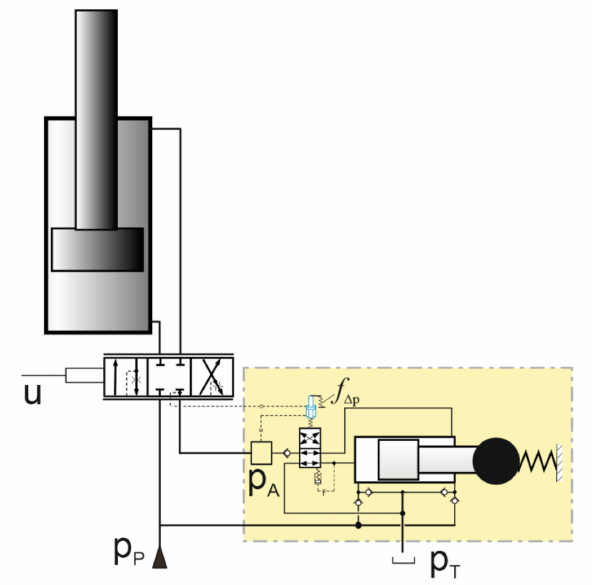
Figure 12. Potential use of the OMC for load sensing meter out speed control of a cylinder